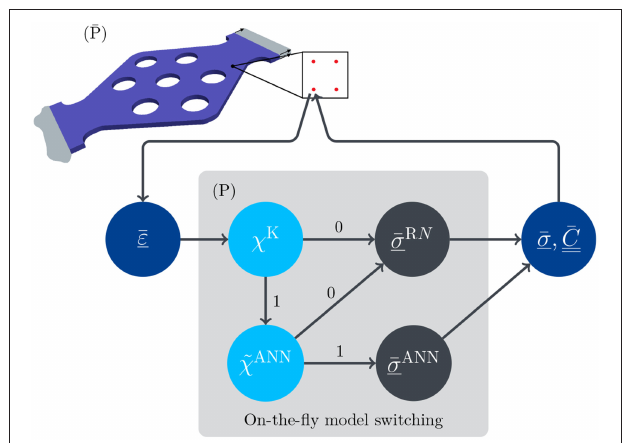
FIGURE 2 | Macroscopic FE boundary value problem ( ¯ P) with on-the-fly model switching at integration points for the computation of the effective microscopic stress ¯ σ for prescribed microscopic effective strain ¯ ε for the microscopic problem (P): first, χ K checks if ¯ ε is in the training region of the ANN surrogate for ¯ σ ; if the quality of ANN is acceptable based on ˜ χ ANN , then ¯ σ ANN is evaluated and passed to the macroscopic FE problem; but if either ¯ ε is outside of the ANN training range or the ANN surrogate is not accurate enough, then a previously selected accurate ROM of corresponding dimension N is evaluated and then passed to the macroscopic